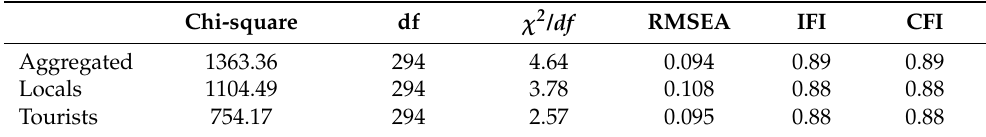
Table 7. SEM parameters.